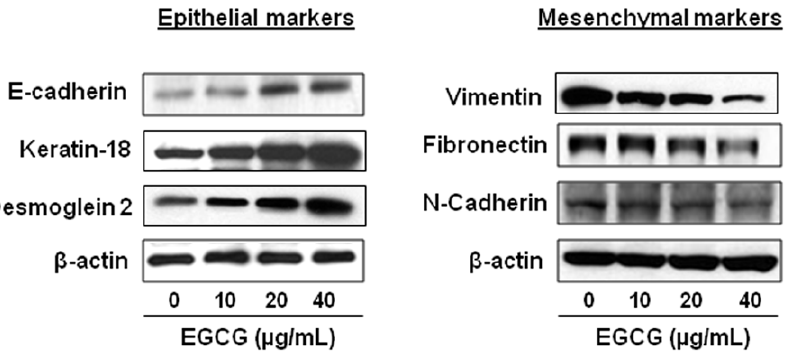
Figure 7. Treatment of melanoma cells with EGCG results in mesenchymal-to-epithelial transition. Treatment of A375 cells with EGCG for 24 h enhances the levels of epithelial biomarkers in the cells, such as, the levels of E-cadherin, keratin-18 and desmoglein 2. Simultaneously the levels of mesenchymal biomarkers in melanoma cells, such as, vimentin, fibronectin and N-cadherin were decreased dose-dependently. Western blot analysis was performed as detailed under Materials and Methods. Representative blots are shown from three independent experiments with similar results.